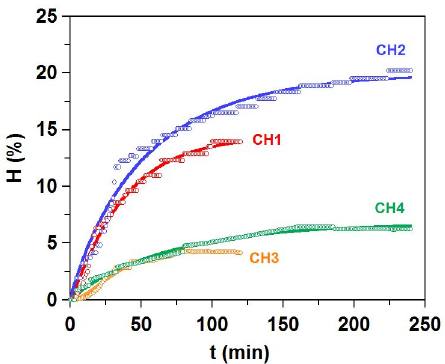
Figure 6. Proteolysis kinetics of salmon skins residues by alcalase (CH1 and CH2) and papain (CH3 and CH4). Experimental data of hydrolysis degree (H, symbols) were fitted to the Weibull equation (continuous line).